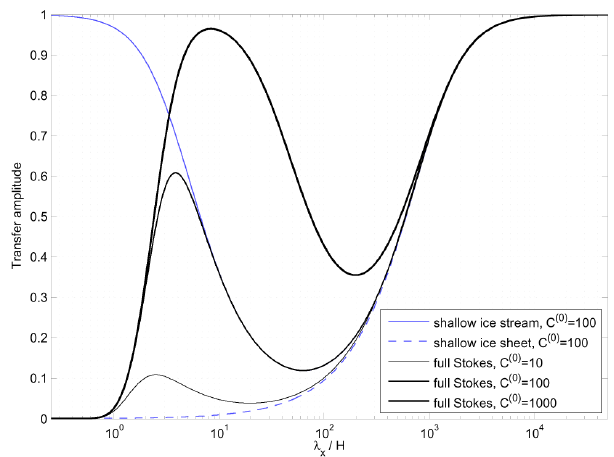
Fig. 1. Two-dimensional steady-state transfer amplitude T sb (λ x ) for α = 0 . 003rad and three values of the mean slip ratio: C ( 0 ) = 10, C ( 0 ) = 100 and C ( 0 ) = 1000. Black curves represent the full Stokes solution (Gudmundsson, 2003), whereas dashed and dotted blue lines correspond to the shallow ice stream and shallow ice sheet ap- proximation, respectively (Gudmundsson, 2008). All solutions are given for a linear ice rheology and linear sliding